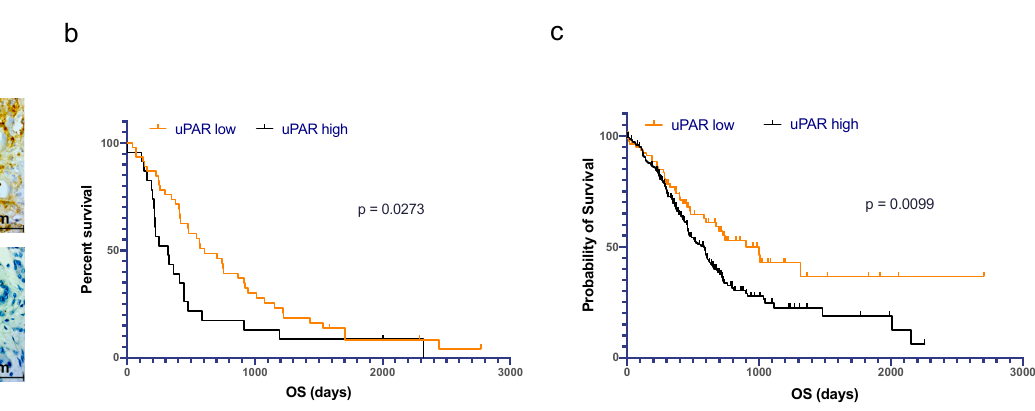
Figure 1. Prognostic significance of uPAR expression in PDAC patients. ( a ) Exemplary immuno- histochemical staining of PDAC with high vs. low expression of uPAR. ( b ) Statistically significant difference in OS for n = 67 PDAC patients with high (orange, n = 45) vs. low (black, n = 22) im- munohistochemical expression of uPAR. ( c ) Statistically significant difference in OS for n = 83 PDAC patients with high (black) vs. n = 219 patients with low (orange) expression levels of uPAR mRNA (source: TCGA dataset).